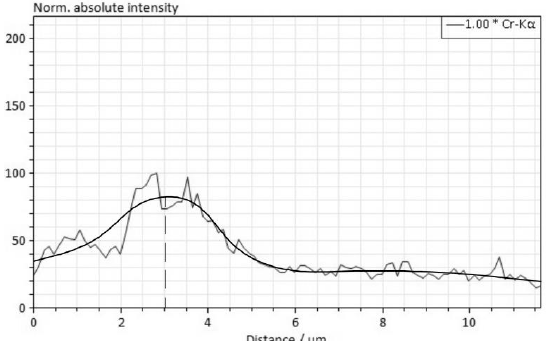
Fig. 6. Change of chromium concentration inwards from the surface of sample№3